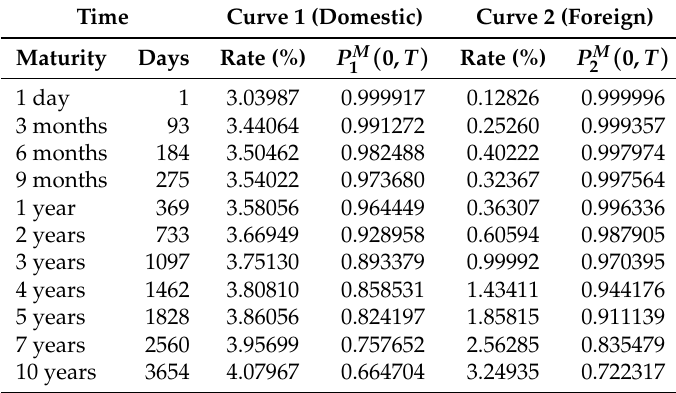
Table 2. Zero rate curves for numerical tests. All rates are continuously compounded with actual/365 yield convention. Time Curve 1